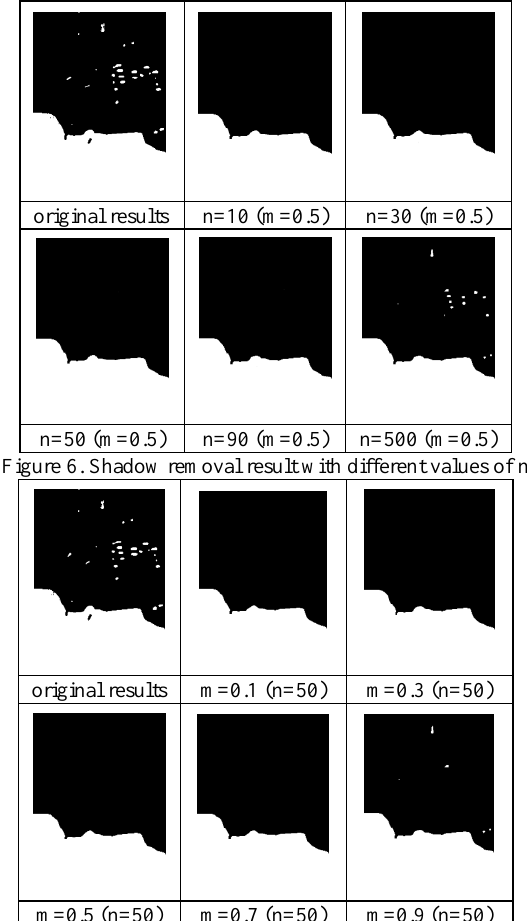
Figure 7. Shadow removal result with different values of m